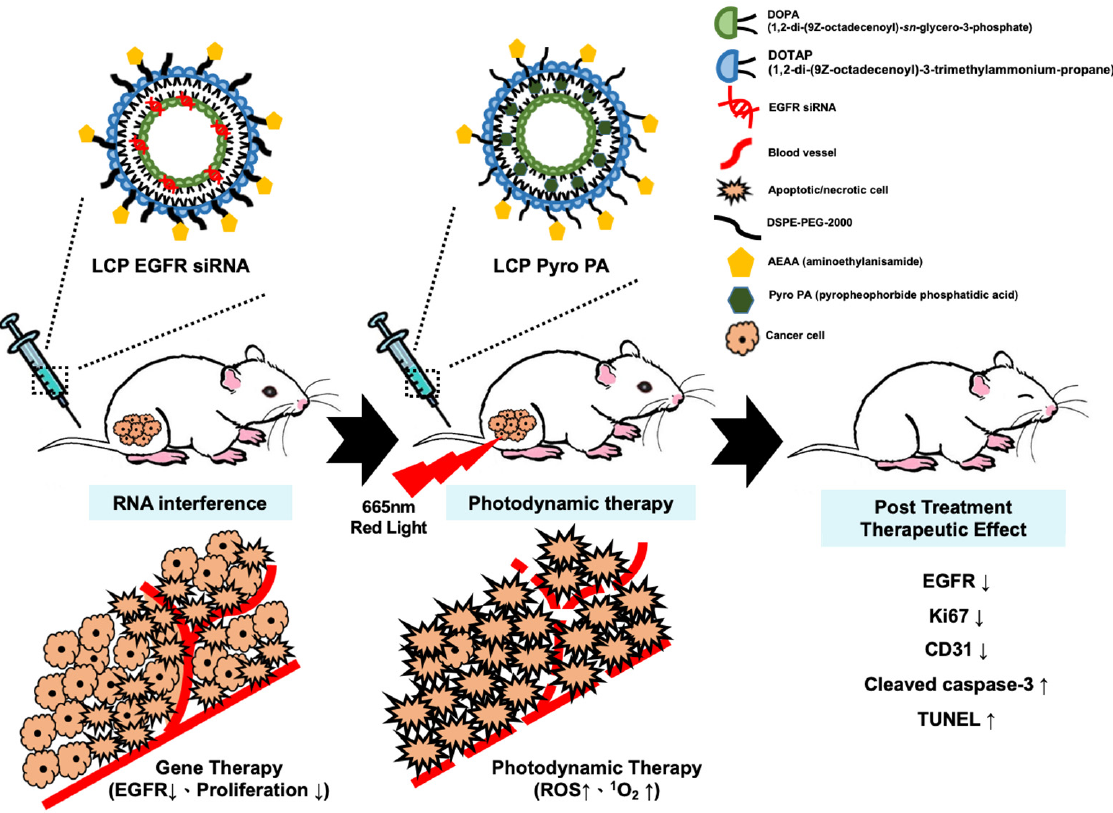
Scheme 1. Schematic illustration of LCP EGFR siRNA and LCP Pyro PA to xenograft models. We used SCC4 and SAS xenografts of Balb/c nude mice to verify the efficacy of the combination therapy. Combined therapy showed greater tumor growth inhibition for both SCC4 and SAS.